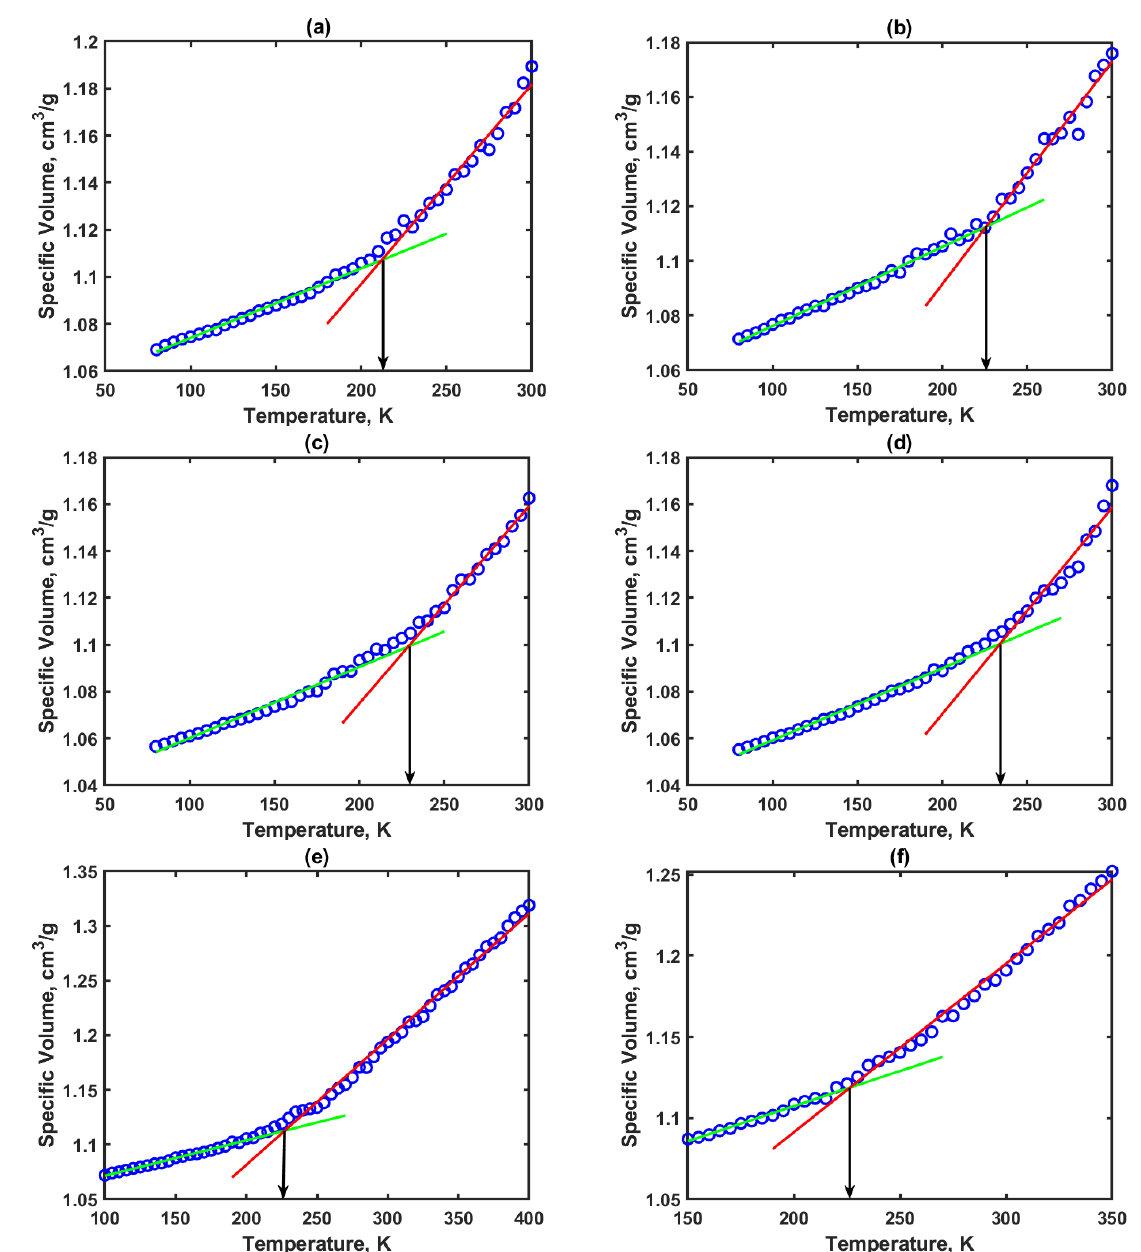
Figure 6. Specific volume vs. temperature profiles for evaluation of T g : ( a ) PE alone; ( b ) PE and 5.2 wt% wax; ( c ) PE and 17.1 wt% wax; ( d ) PE and 29.2 wt% wax; ( e ) PE and 40.8 wt% wax; ( f ) PE and 45.2 wt% wax (green straight line represents glassy region fit and red straight line represents rubbery region fit).